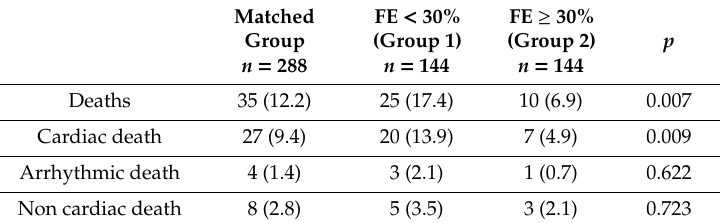
Table 4. Causes of death.